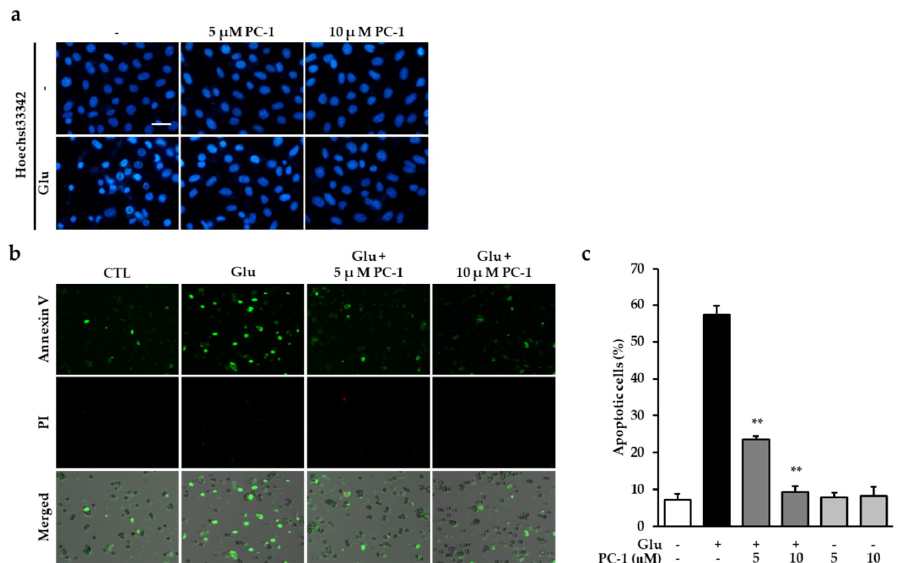
Figure 3. Procyanidin C1 prevented glutamate-induced apoptosis in HT22 cells. ( a ) After 12 h exposure to 5 mM glutamate in the presence or absence of 5 or 10 µM PC-1, the nuclei were visualized with Hoechst 33342. Fluorescent images were acquired using a fluorescent microscope. Scale bar, 20 µm. ( b ) HT22 cells were exposed to 5 mM glutamate in the presence of 5 or 10 µM PC-1 for 10 h and stained with Alexa Fluor 488-conjugated annexin V and PI to evaluate the number of apoptotic and dead cells, respectively. ( c ) Images were quantitatively analyzed using TaliPCApp software. Bars denote the percentage of annexin V-positive cells (apoptotic cells). Data are presented as the mean value ± S.E.M. ** p < 0.001 versus glutamate-treated HT22 cells.